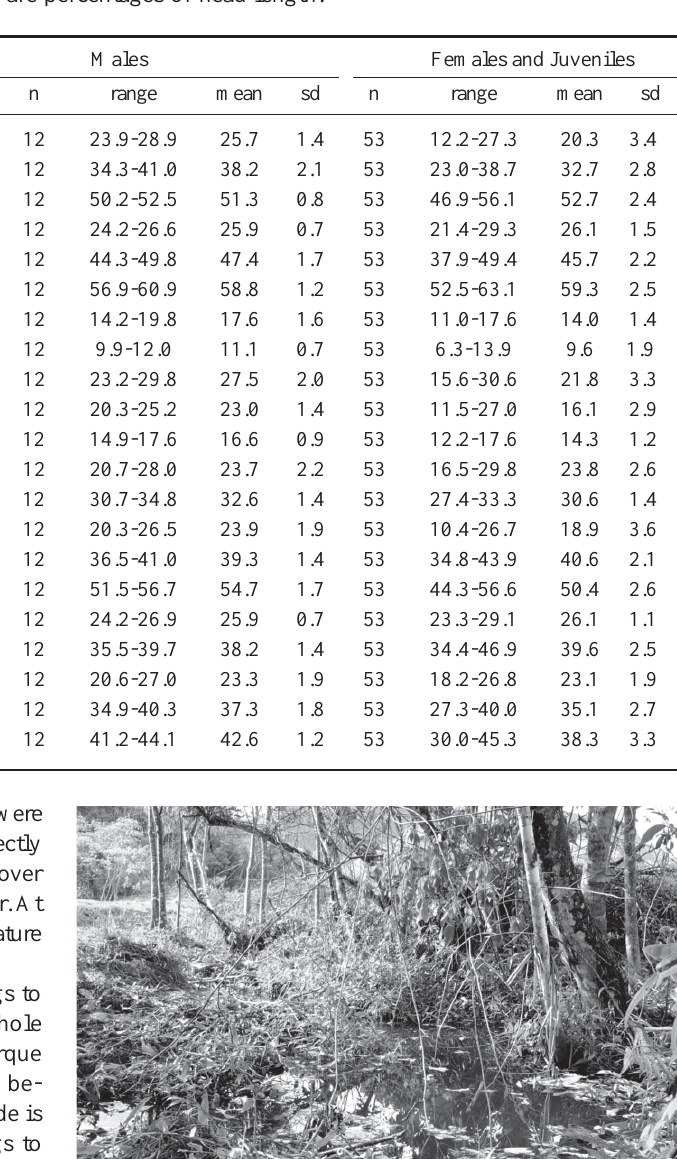
Table 1 . Morphometrics of Lophiobrycon weitzmani . Standard length is expressed in mm; measurements through head length are percentages of standard length; the last four entries are percentages of head length.